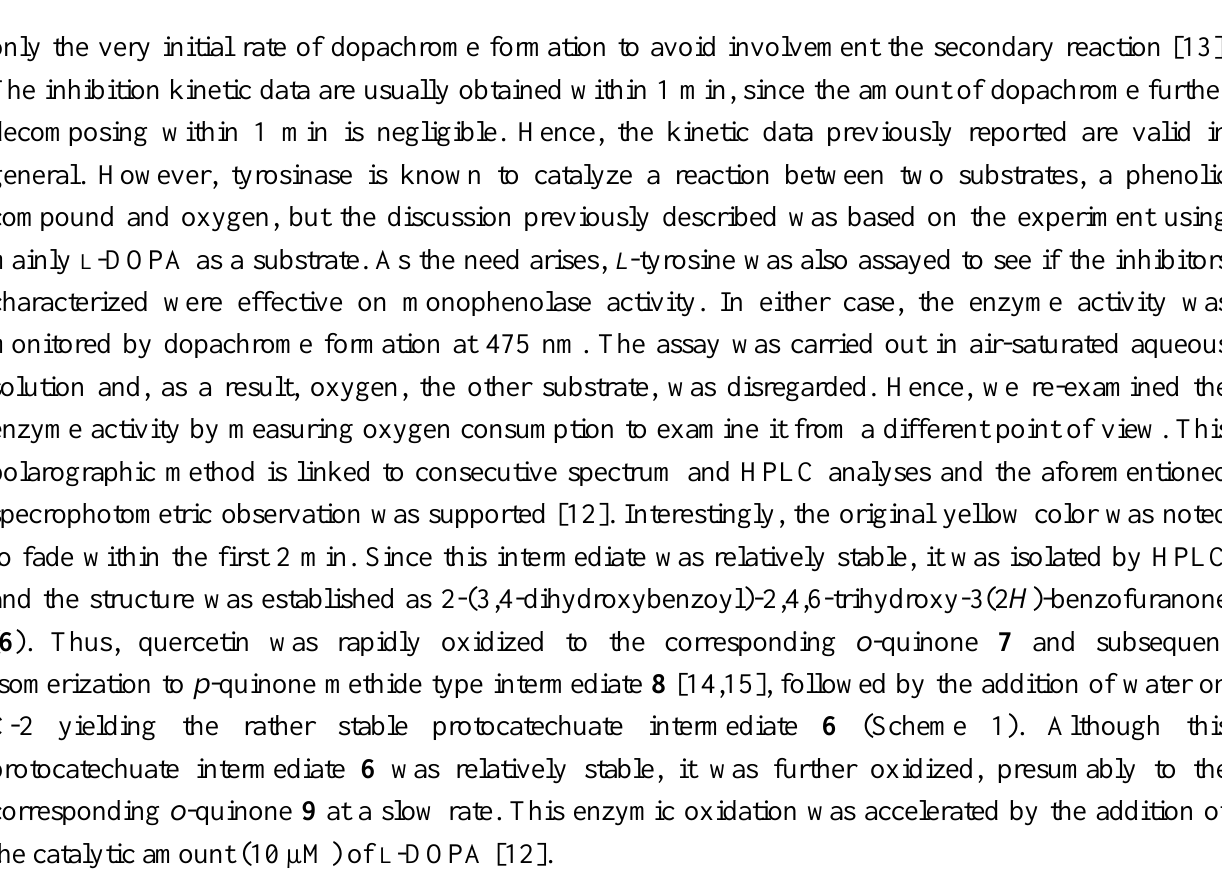
Scheme 1 . Proposed mechanism for the oxidative degradation of quercetin ( 1 )